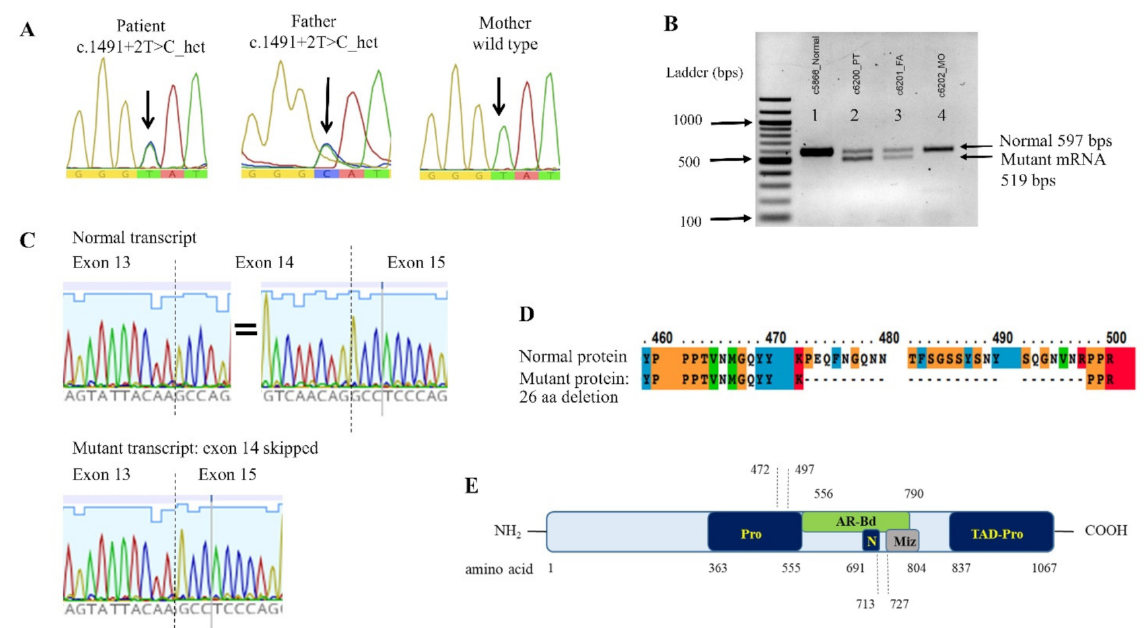
Figure 3. ZMIZ1 genomic and mRNA analysis. ( A ) Genomic DNA sequence of exon 14 identifying heterozygous T > C variant in the proband and the father. ( B ) mRNA (cDNA) product of ZMIZ1 exons 12–17, shown on 2% agarose gel. The normal control (lane 1) and the mother (MO, lane 4) exhibit only normal sized 597-bp product, whereas the patient (PT, lane 2) and the father (FA, lane 3) show both normal (597 bp) and aberrant (519 bp) mRNA products. ( C ) Sequence of the normal mRNA transcript and the mutant transcript with exon 14 skipped. ( D ) Clustal sequence alignment of the wild type and the mutant ZMIZ1 proteins. Noted is an in-frame deletion of 26 amino acids. ( E ) Partial schematic diagram of ZMIZ1. Noted is the location of the 26-aa deletion (aa 472–497) in proline-rich region (Pro). AR-Bd, primary binding region for androgen receptor; N, nuclear localization signal; Miz, Miz domain; TAD-Pro, transcriptional activation domain